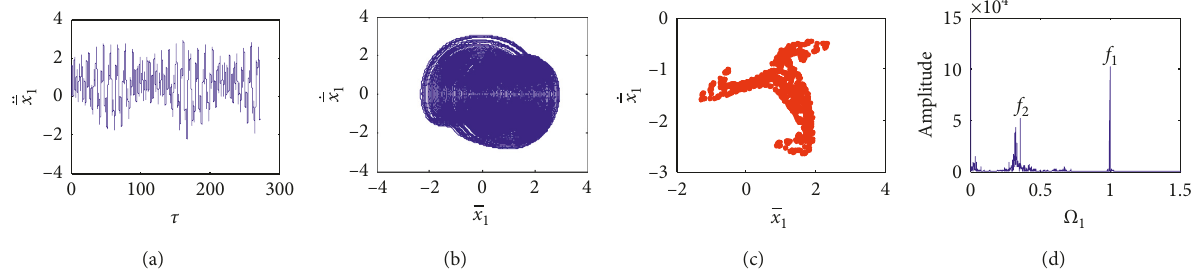
Figure 10: Vibration characteristics when Ω � 1.8: (a) time domain, (b) phase diagram, (c) Poincar´e section, and (d) frequency 1